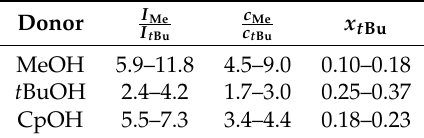
Table 1. Experimental integrated intensity ratios I Me / I t Bu , B3LYP-D3(BJ,abc)/def2-TZVP cross-section derived docking ratios c Me / c t Bu and resulting experimental fractions x t Bu for t Bu docking. The given ranges represent 95% confidence for I Me / I t Bu using an automated statistical evaluation [24] and are carried on to c Me / c t Bu and x t Bu without including a theoretical cross section ratio